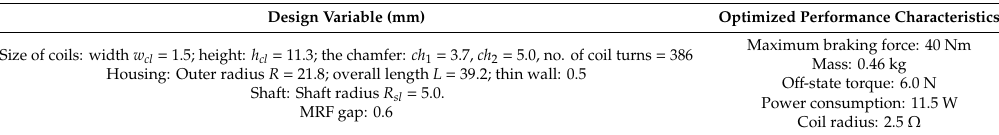
Table 2. Optimal results of the linear MR